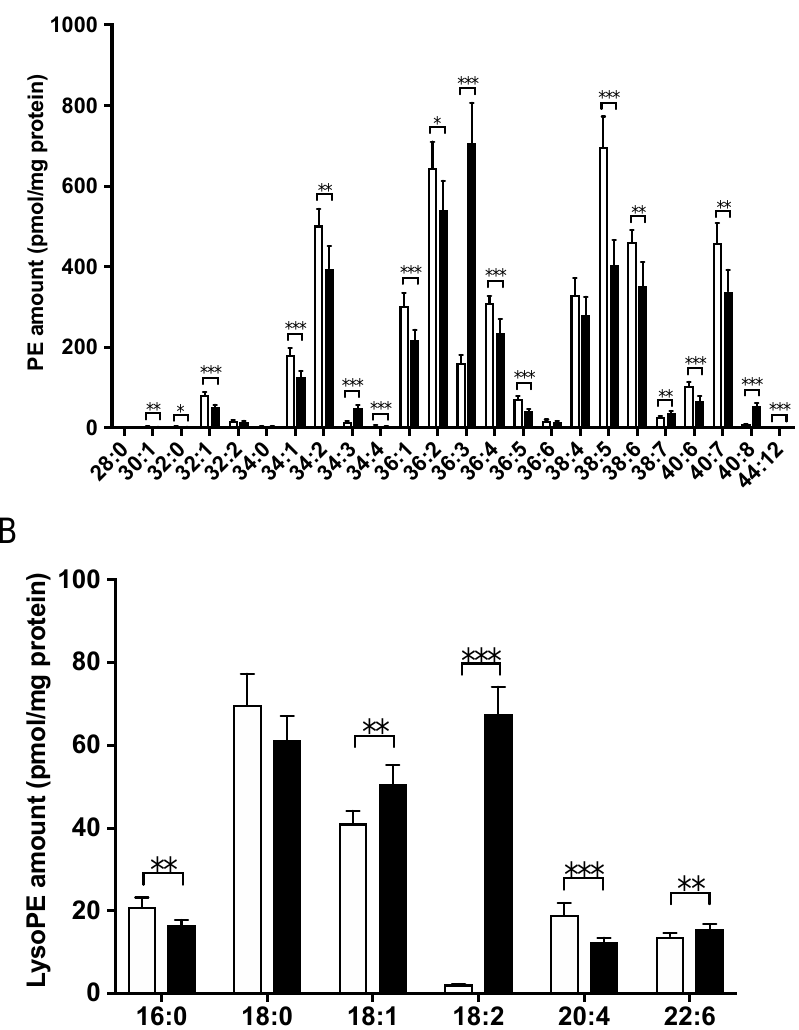
Figure 5. Comparison of PE ( A ) and lysoPE ( B ) species in lysoPE-supplemented (black bars) and unsupplemented (white bars) C3A cells detected using Orbitrap LC-MS/MS. Results are shown as mean ± standard deviation. n = 6. Student’s t -test, * p < 0.05, ** p < 0.01, *** p < 0.001.